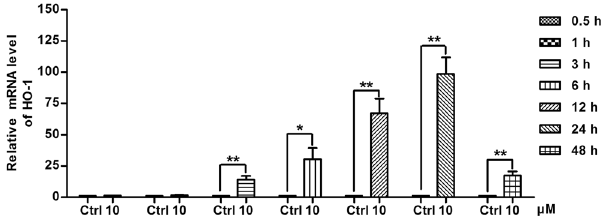
Figure 6. Effects of compound 3d on the mRNA level of HO-1. A549 lung cancer cells were treated with compound 3d at 10 μ M for 0.5, 1, 3, 6, 12, 24, 48 h. The relative mRNA level of HO-1 was detected by quantitative reverse transcription–polymerase chain reaction (qRT-PCR). Results are mean ± SEM ( * p < 0.05, ** p < 0.01 vs control. N = 3).